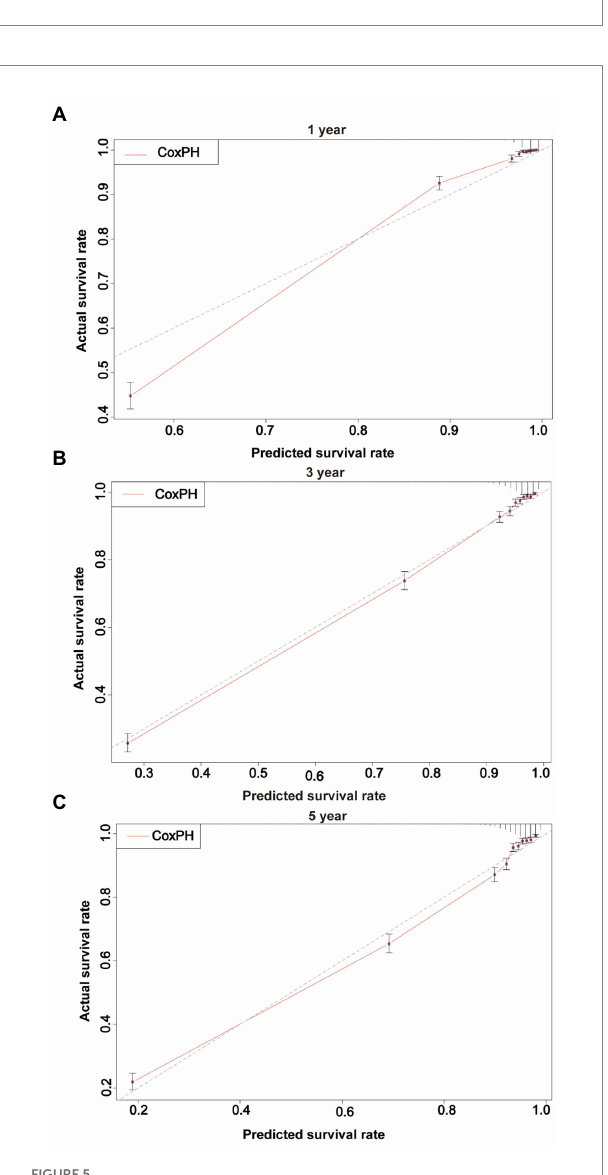
FIGURE 5 Calibration plots of survival rate of CMM in Cox PH model.